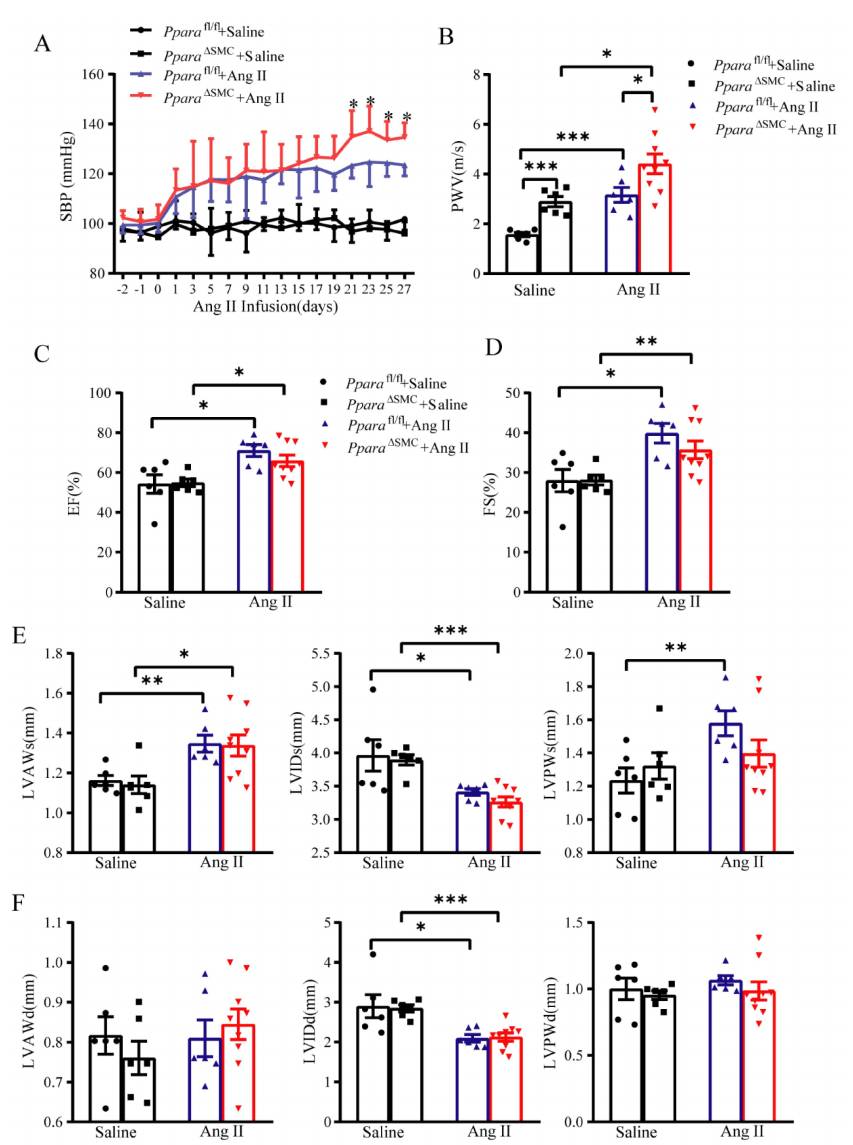
Figure 2. PPAR α deficiency in VSMCs aggravated Ang II − induced hypertension and vascular stiffness independent of cardiac function. ( A ) Systolic blood pressure (SBP) was measured by noninvasive tail–cuff method before and after saline or Ang II infusion (490 ng/kg/day). ( B ) Pulse wave velocity (PWV) was measured by vascular ultrasound after Saline or Ang II infusion. ( C ) Ejection fraction (EF) and ( D ) fractional shortening (FS) were assessed by two-dimensional echocardiography after saline or Ang II infusion. Left ventricular anterior wall (LVAW) thickness, left ventricular internal diameter (LVID), and left ventricular posterior wall (LVPW) thickness at end-systole (s, E ) or end-diastole (d, F ) are recorded and analyzed ( n = 6–9, two-way ANOVA). Data are means ± SEM. * p < 0.05, ** p < 0.01, *** p < 0.01 between